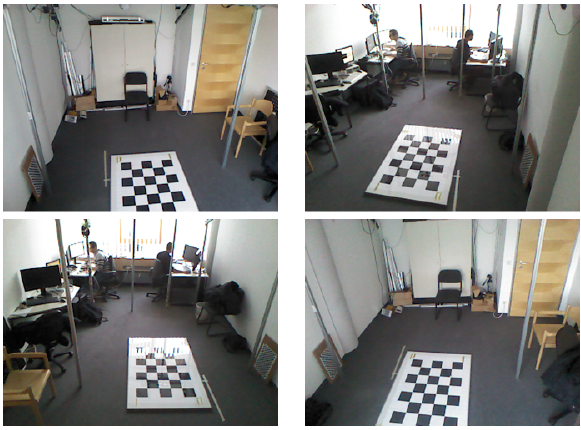
Figure 2: Chessboard pattern seen from four Kinects second preprocessing step, where un-useful points in the back- ground, not part of the active FOV, can be removed. Therefore we trim the point cloud in the Z (depth) direction of the sensor using a predefined threshold set manually by the user. We con- sidered trimming points which are not (in depth) part of the